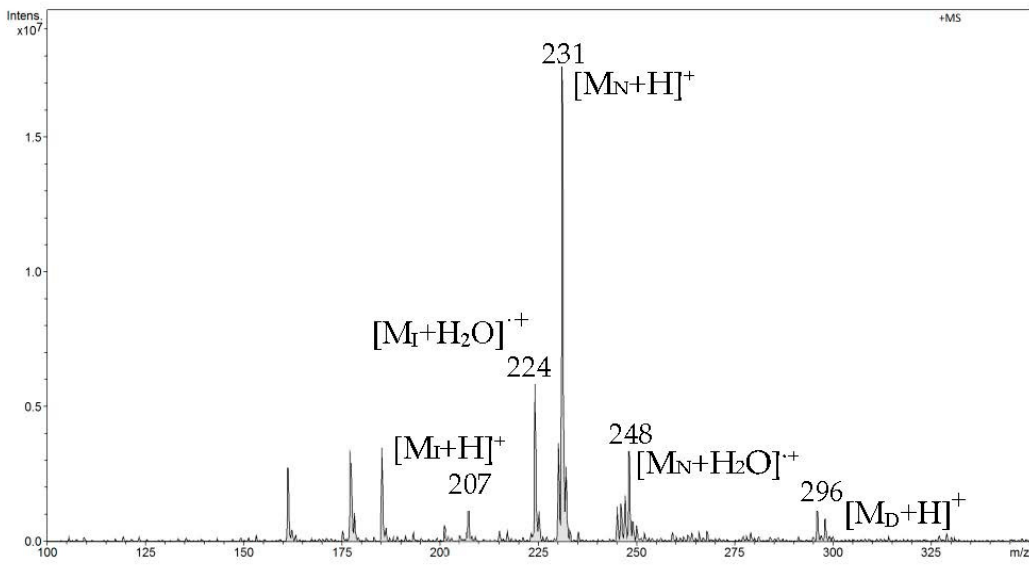
Figure 10. FAPA ‐ MS spectrum recorded in the second heating phase from 120 °C to 155 °C.